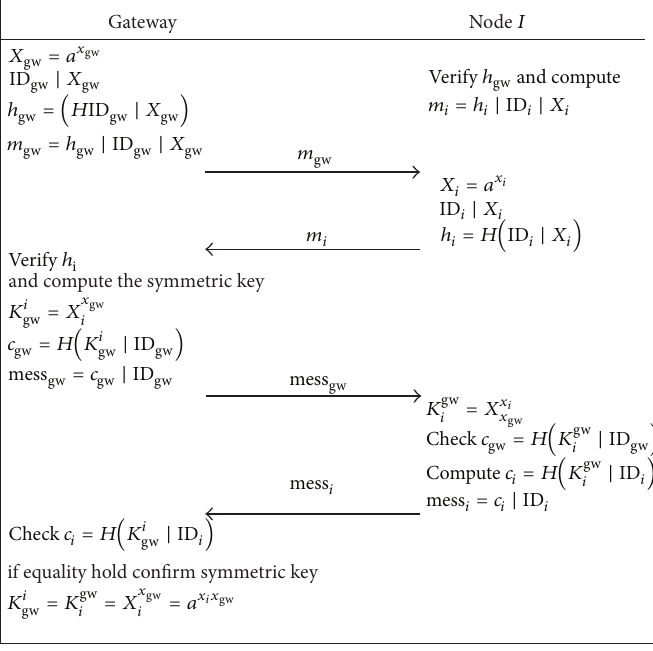
Figure 2: Kamto et al.’s proposed protocol.